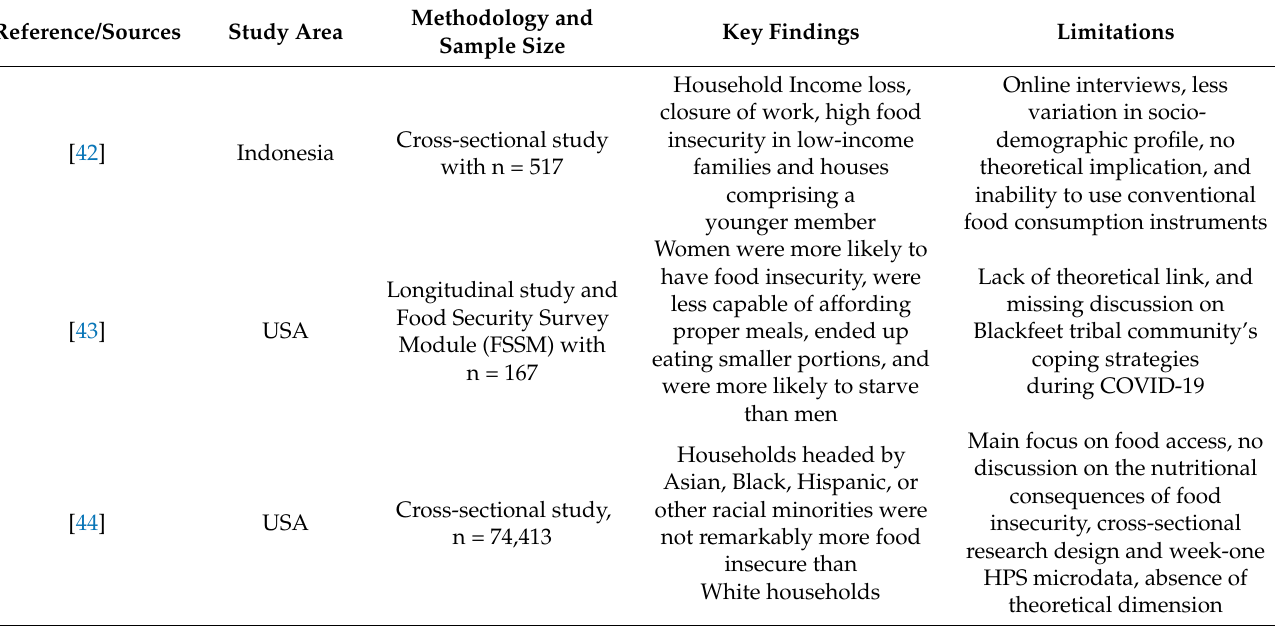
Table 2. Tabular-based literature review about COVID-19 induced food security on indigenous communities